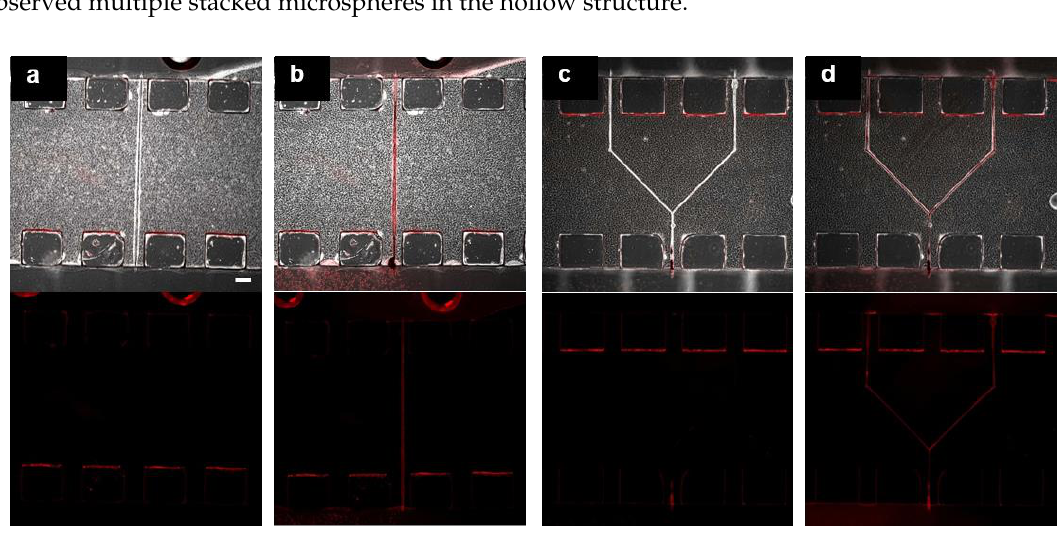
Figure 5. Fabricated hollow structures in a photodegradable hydrogel prepared in the microfluidic device. Merged (top) and fluorescence (bottom) images of the linear ( a , b ) and branched ( c , d ) structures before ( a , c ) and after ( b , d ) introduction of microsphere suspension. (Scale bar: 200 µm.).